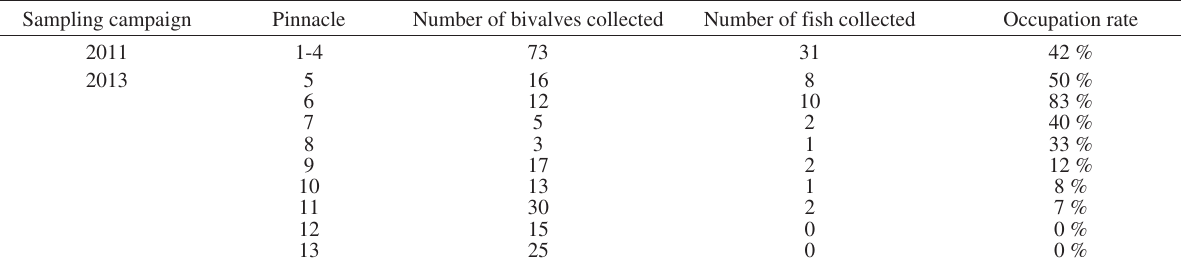
Table 1. – Summary of the occupation rates (i.e. percentage of the collected bivalves Pinctada margaritifera being occupied by carapid fish Onuxodon fowleri ) observed on the 13 reef pinnacles sampled during the two field campaigns (November-December 2011 and October- November 2013). Note: During the 2011 field campaign, we only determined the overall occupation rate related to the four reef pinnacles sampled. Figure 1 gives the exact geographical location of the 13 reef pinnacles.